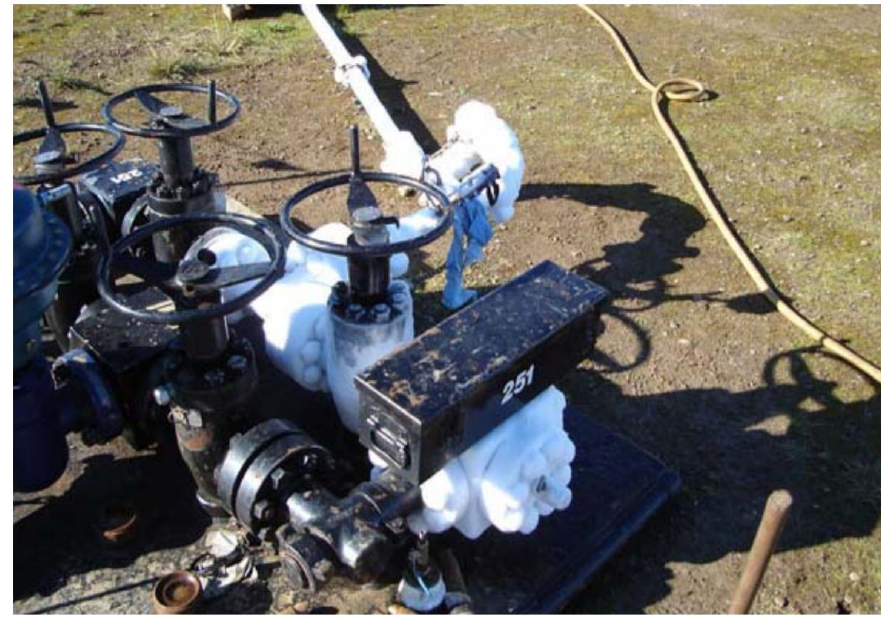
Figure 1. Ice formation from Joule–Thomson (JT) cooling on the exterior of the wellhead system of a CO 2 injection well where CO 2 vaporized from the liquid state to the gas state